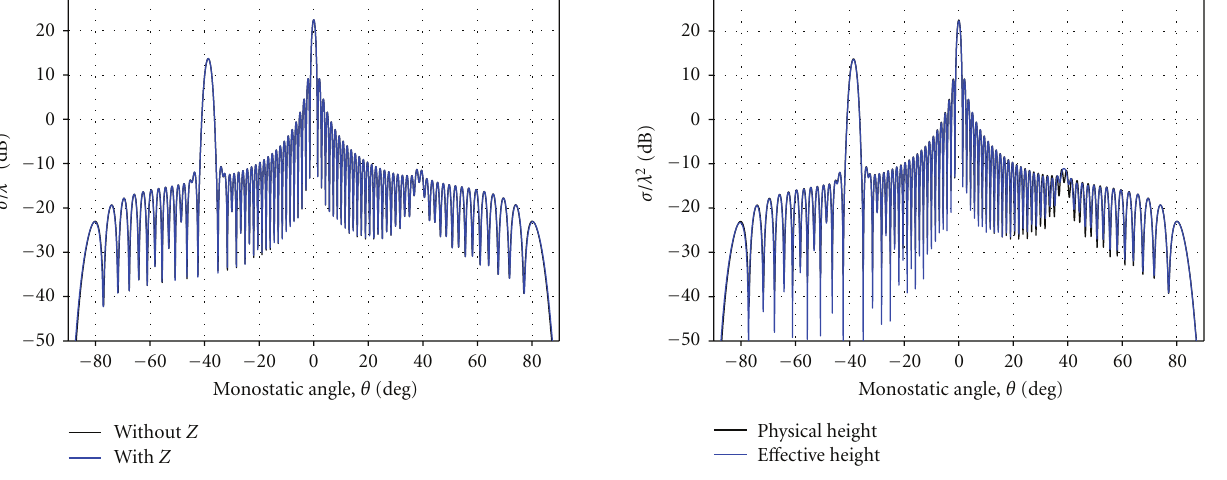
r r r . 2; uniform r = p = c = l = 0